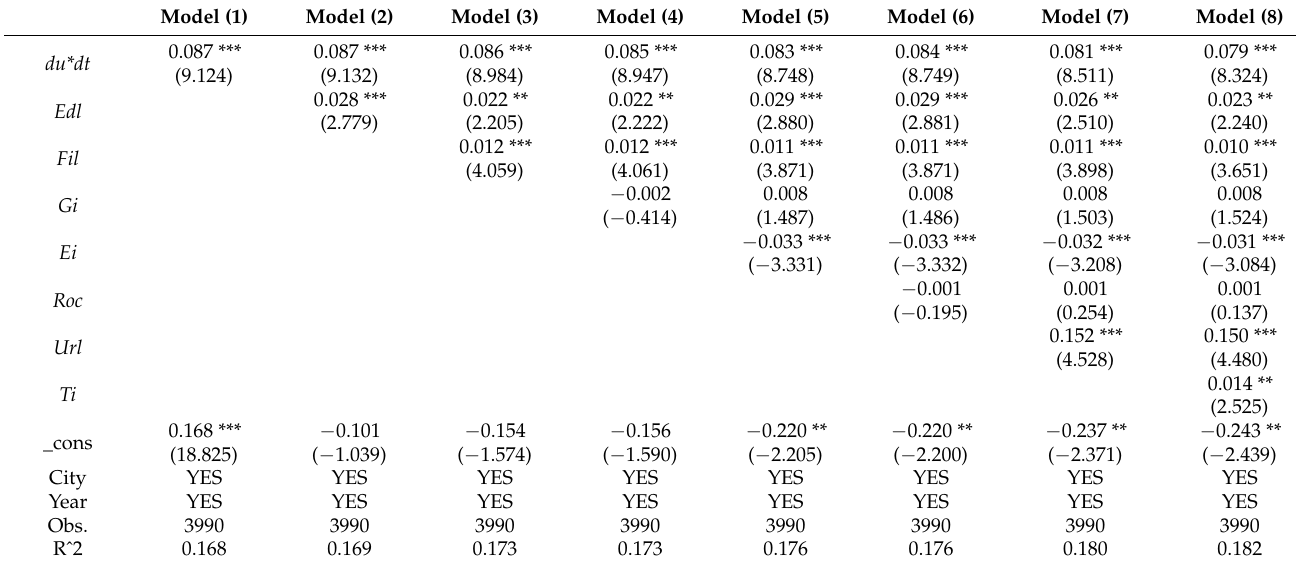
Table 3. Baseline regression